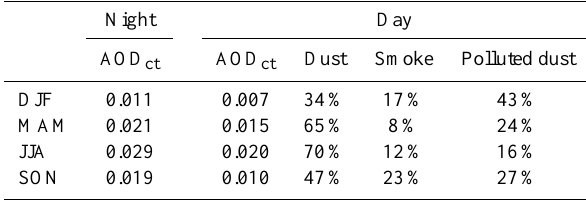
Table 1. Global and seasonal averages of AOD ct above low clouds for nighttime and daytime and the fraction of the daytime data that is classified as dust, smoke, or polluted dust.